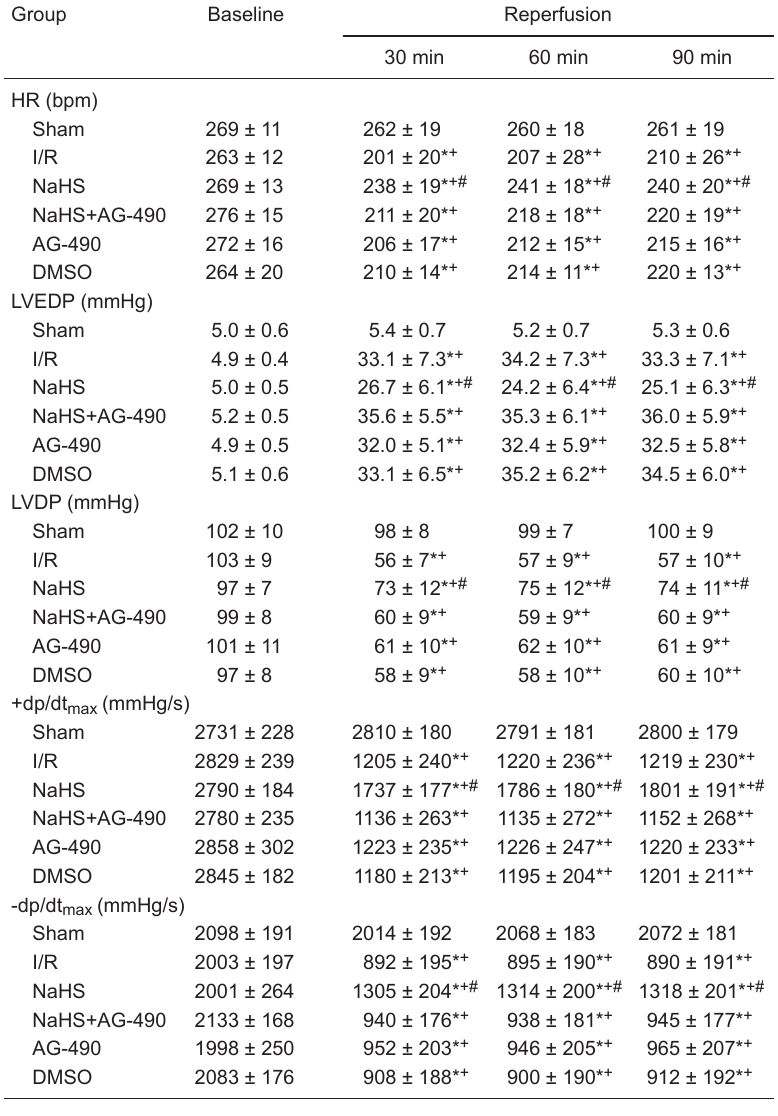
Table 1. Left ventricular